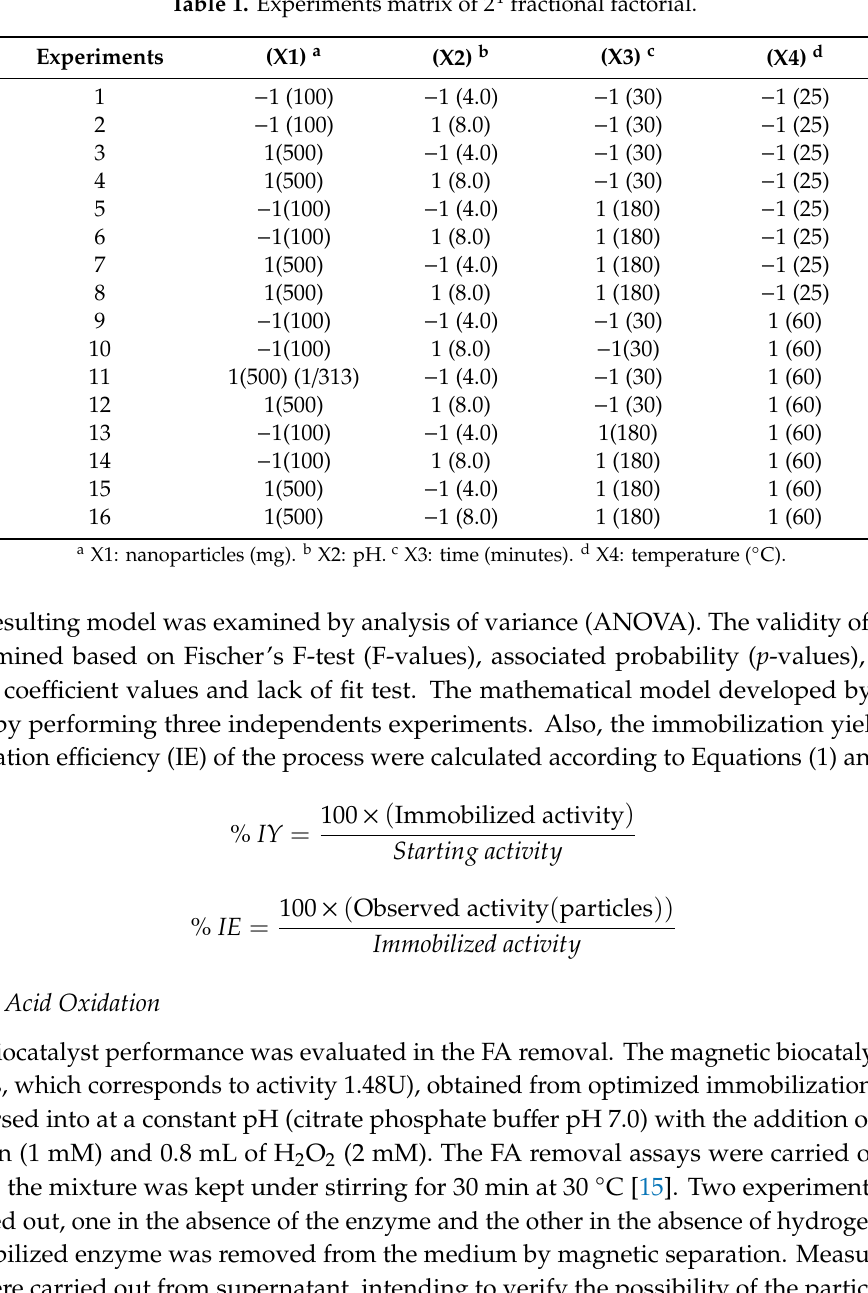
Table 1. Experiments matrix of 2 4 fractional